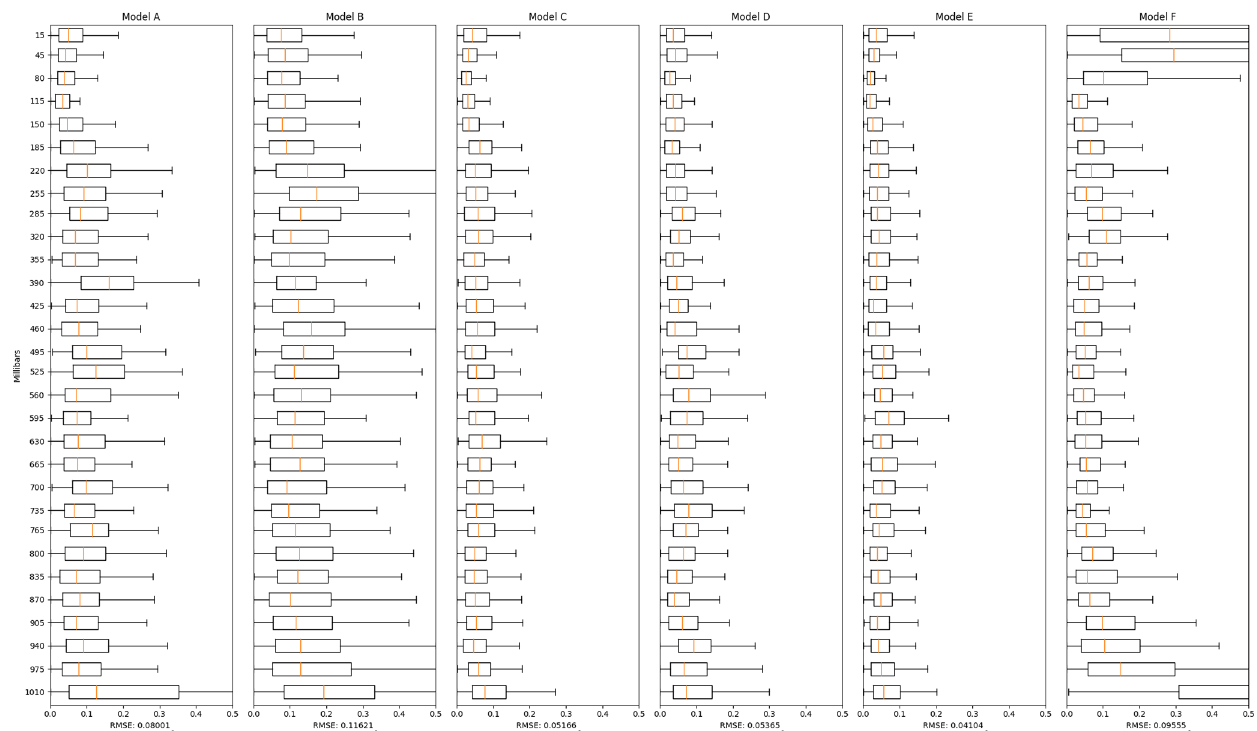
Figure 3. Models are trained with Dataset 2 and evaluated against Dataset 1 . val